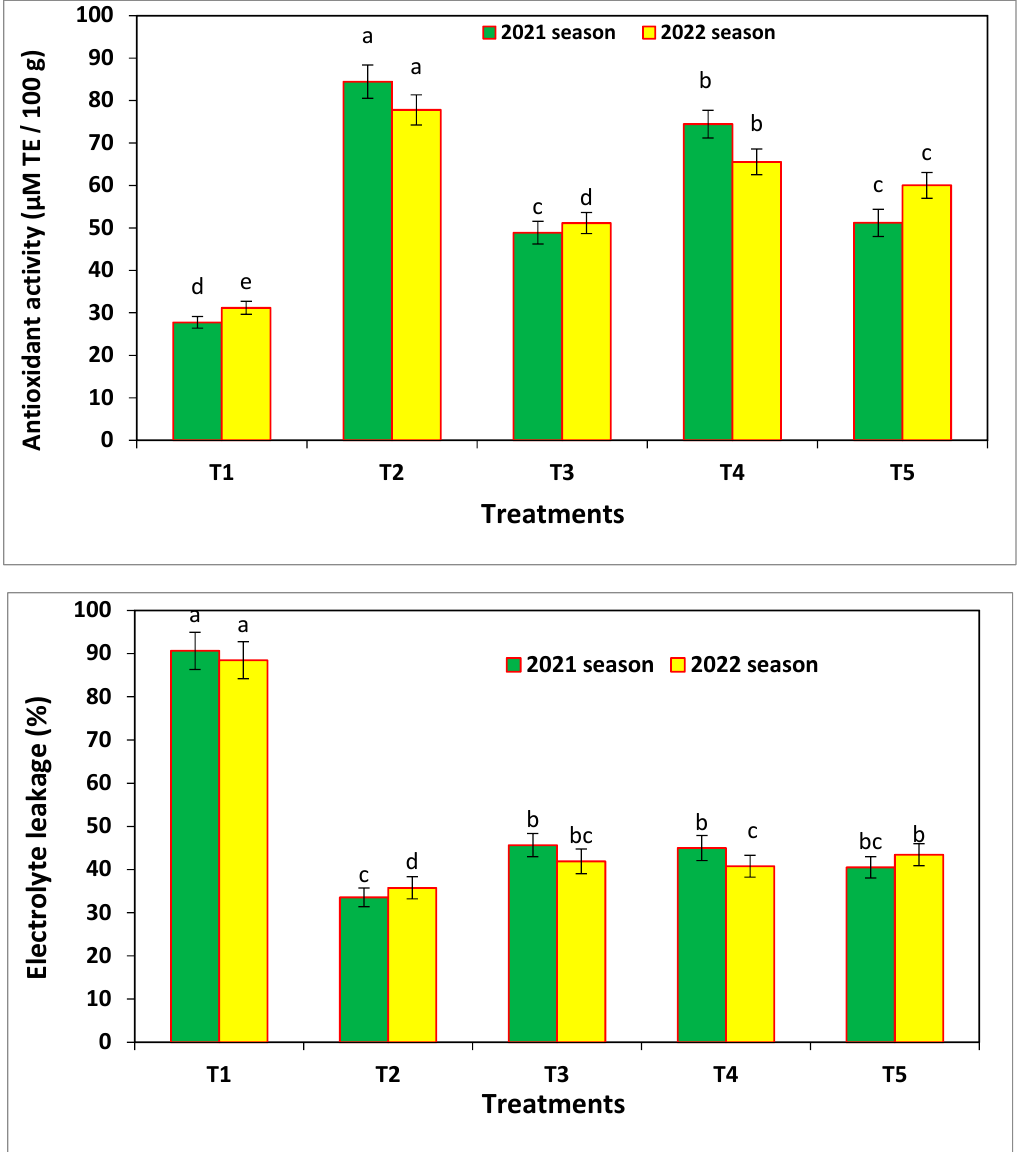
Figure 9. Effects of the different treatments on total antioxidant activity and electrolyte leakage measured 70 days after sowing in the field experiments in 2021 and 2022. Results are given as mean values ± standard error bars and where T1 = negative control, T2 = 100 ppm nano-Se, T3 = 200 ppm nano-Si, T4 = 1/2 nano-Se + Si, and T5 = fungicide (Score 250 EC at 1 mL/2 L). Same letter above the error bar indicates no significant differences. Table 6. Total dry yield of common bean seeds as influenced by different treatments. Results from the field experiments, and where T1 = negative control, T2 = 100 ppm nano-Se, T3 = 200 ppm nano-SiO 2 , T4 = 1/2 nano-Se + SiO 2 , and T5 = fungicide (Score 250 EC at 1 mL/2